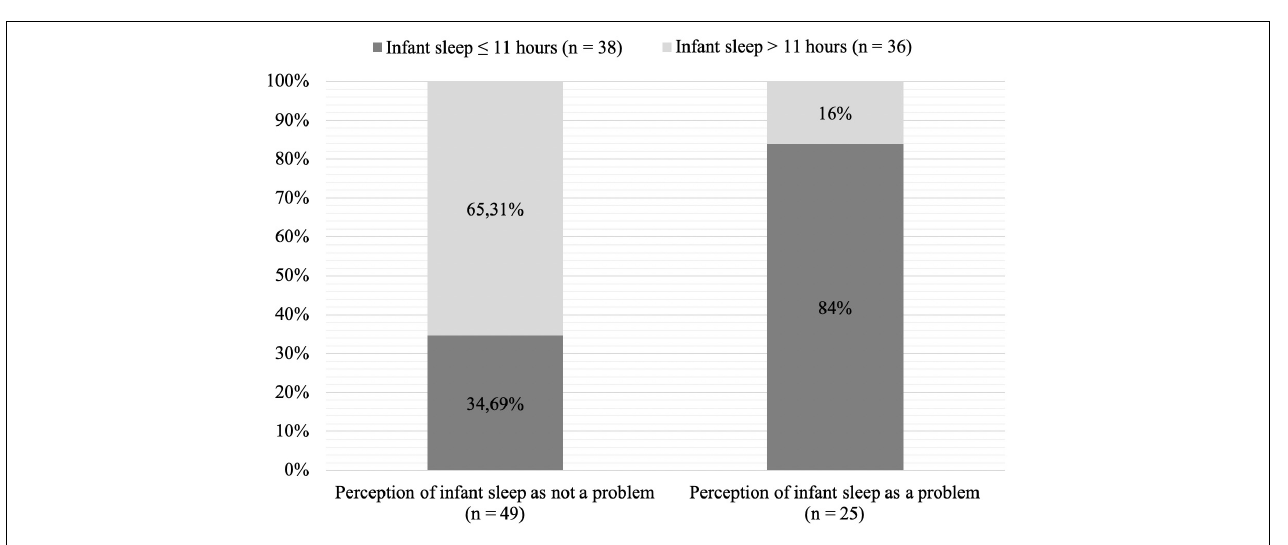
FIGURE 1 | Chart of maternal perception of infant sleep by amount of infant nocturnal sleep ( χ 2 (1, 74) = 16.11, p <